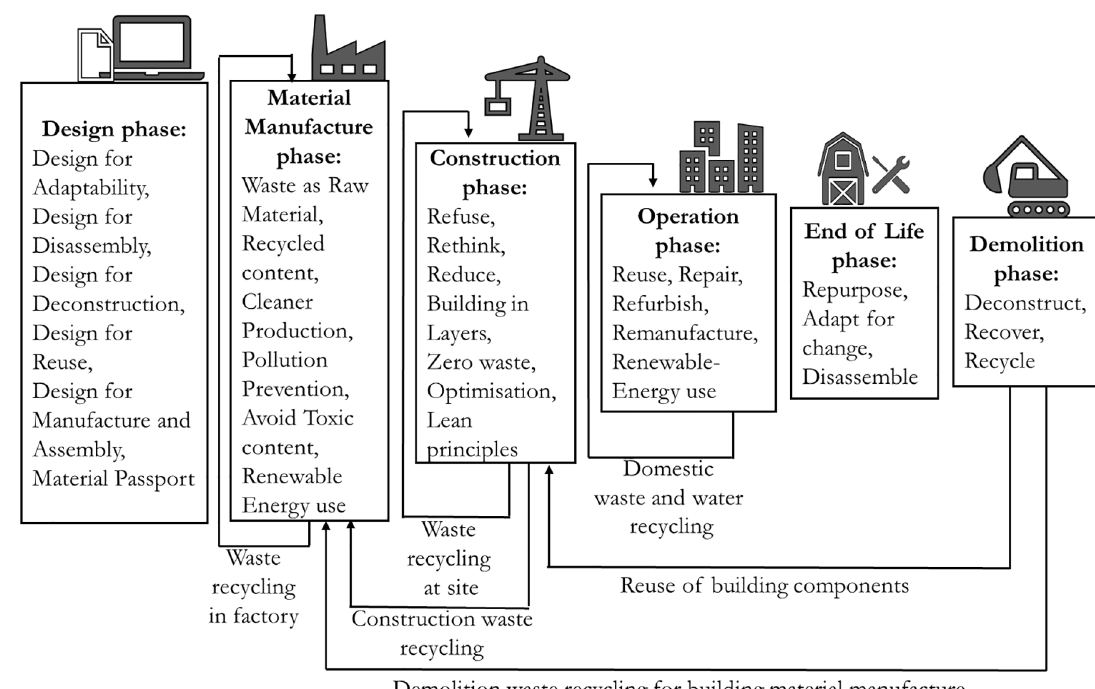
Figure 4. Integrated model for CE in the various life cycle stages of the built